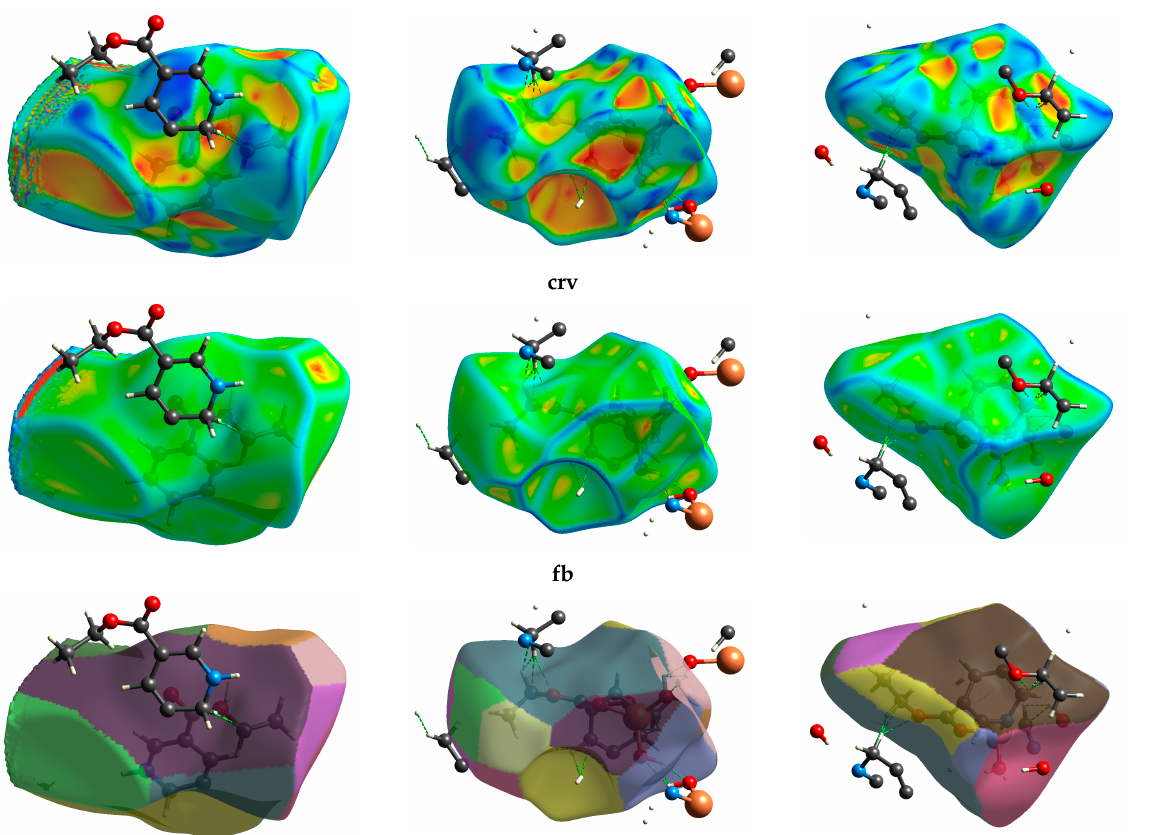
Figure 12. Molecular Hirshfeld fingerprints dnorm, di, de, shape index“si.” and curvedness “crv”, and fragment batch “fb” in compound 2a,b.